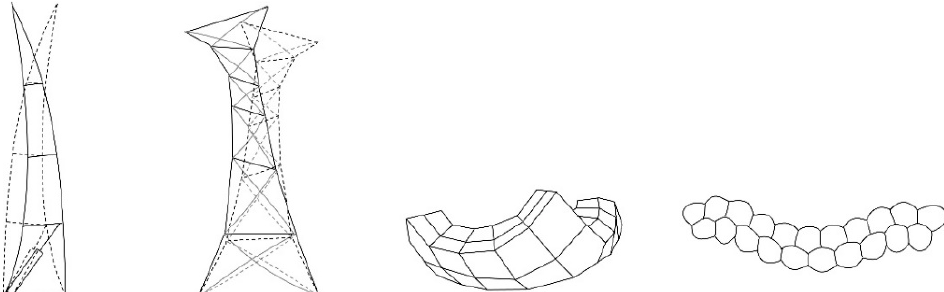
Figure 1. Pneumatically actuated structures: InteractiveWall actuated by hard actuators—air pistons; Muscle Tower 2 actuated by soft muscles; Dynamat and Prototype of varying morphology beam as structures with volumetric actuators.